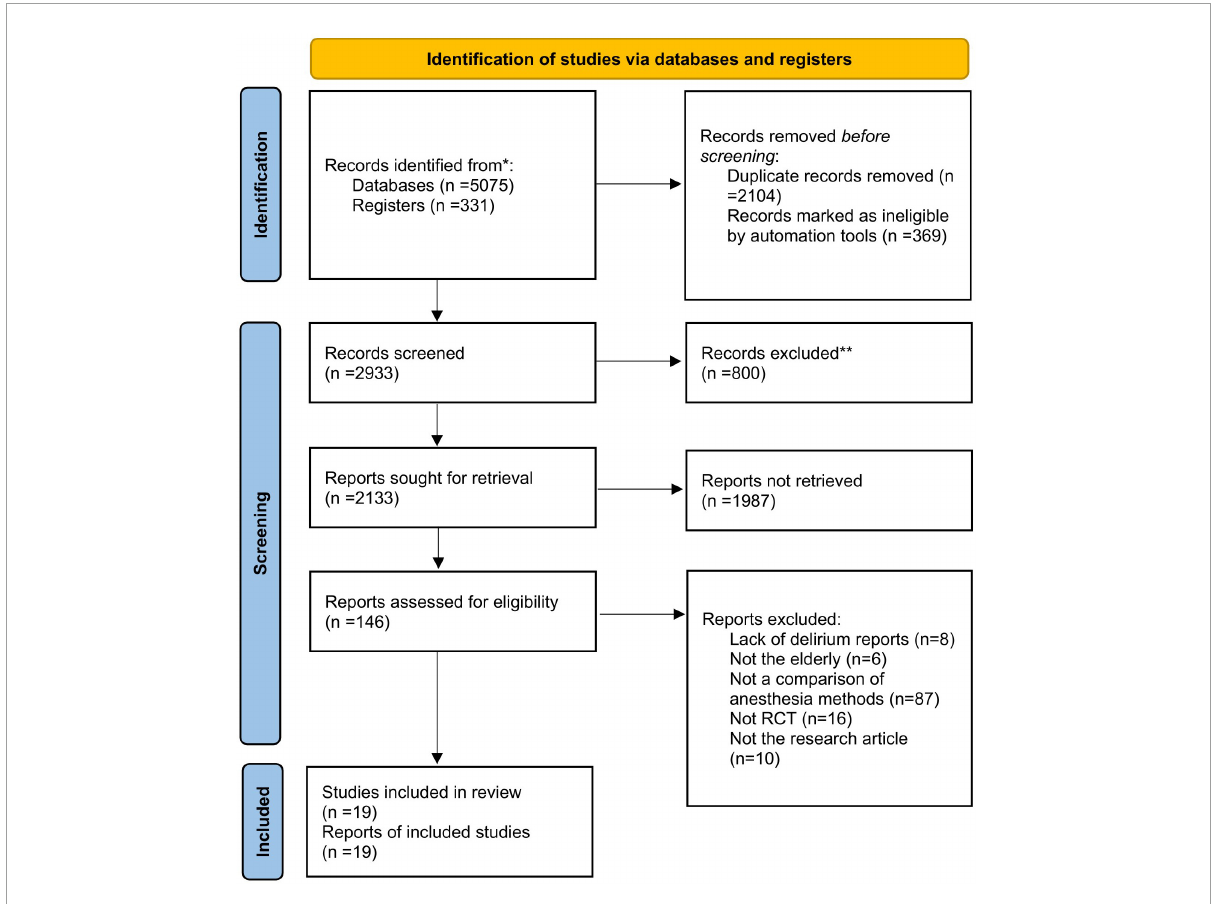
FIGURE1 PRISMA flow diagram of the search strategy and included